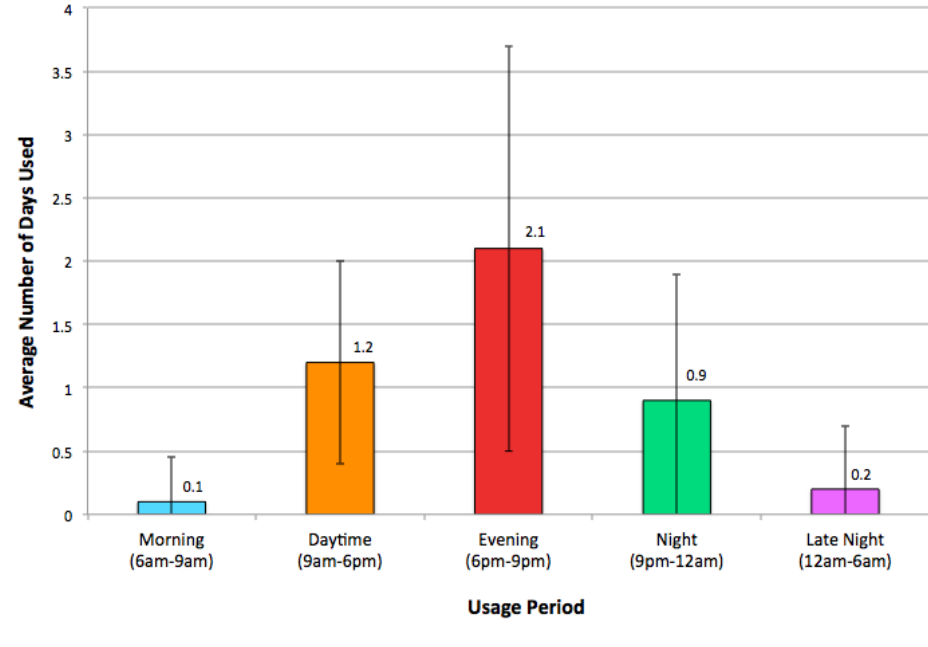
Figure 3. Average number of days within the usage period on which participants engaged with the app during specific time periods (within 1 standard